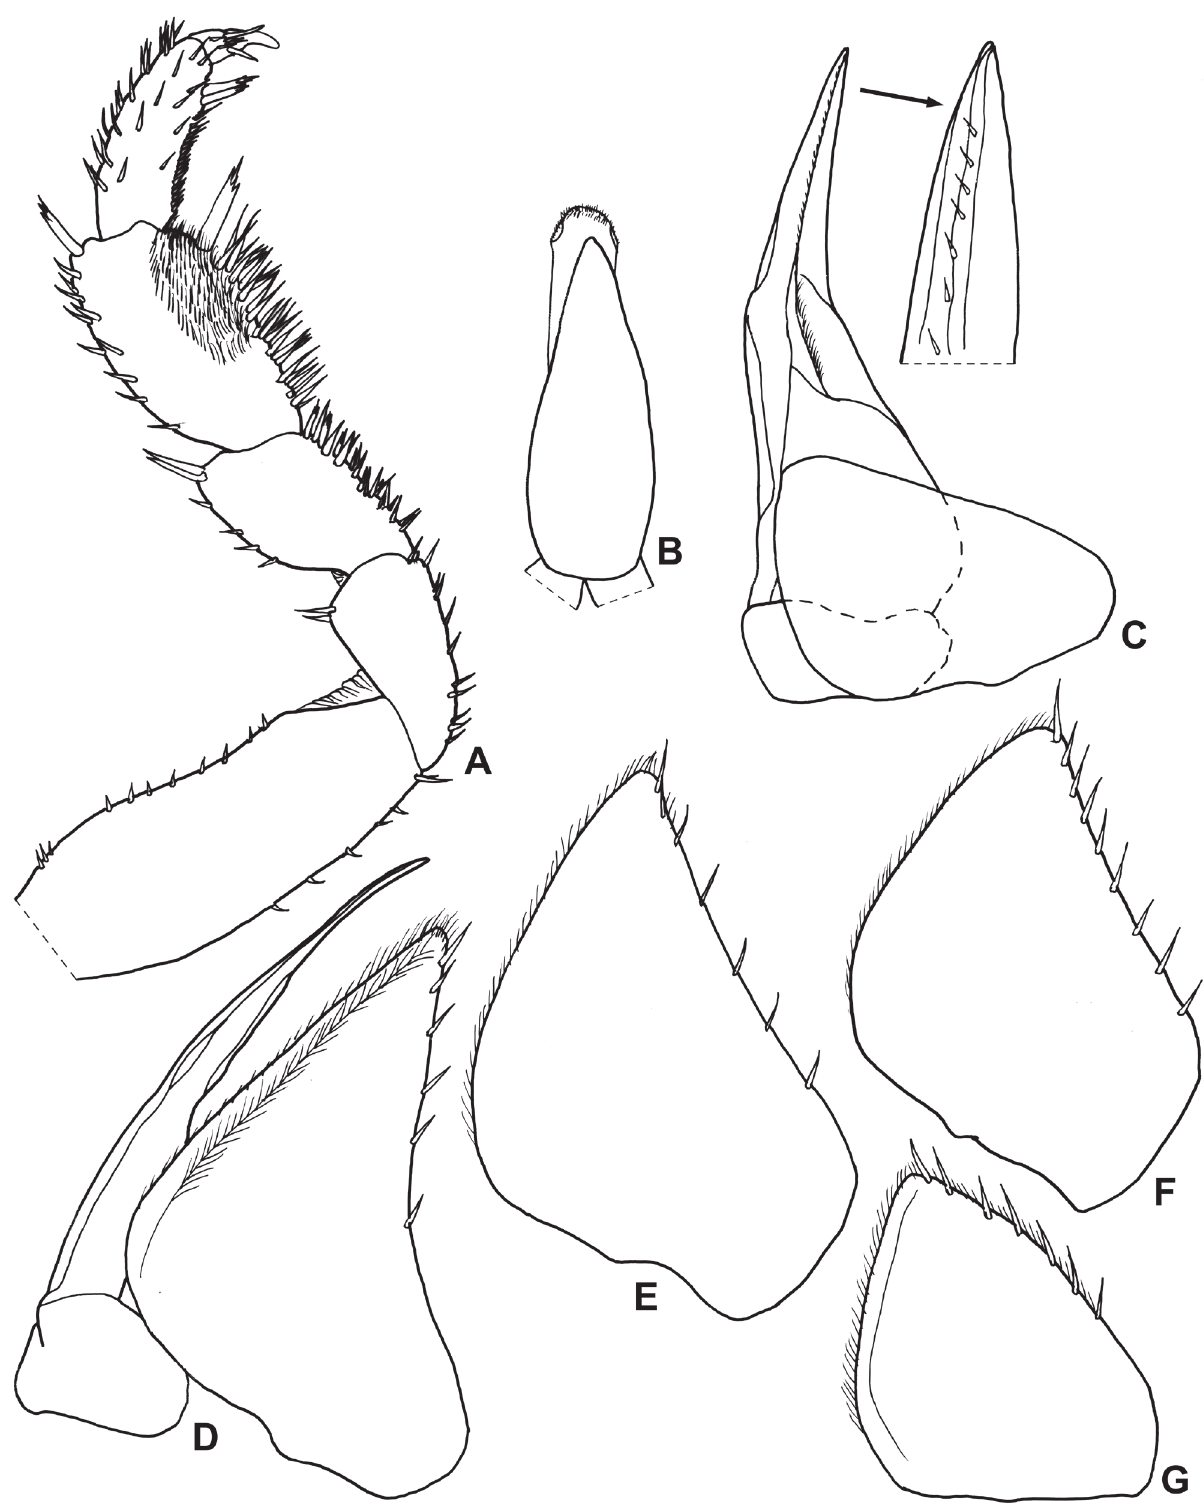
Figure 10. Trichorhina cipoensis n. sp. (male paratype). A, pereopod 1; B, genital papilla; C, pleopod 1; D, pleopod 2; E, pleopod 3 exopod; F, pleopod 4 exopod; G, pleopod 5